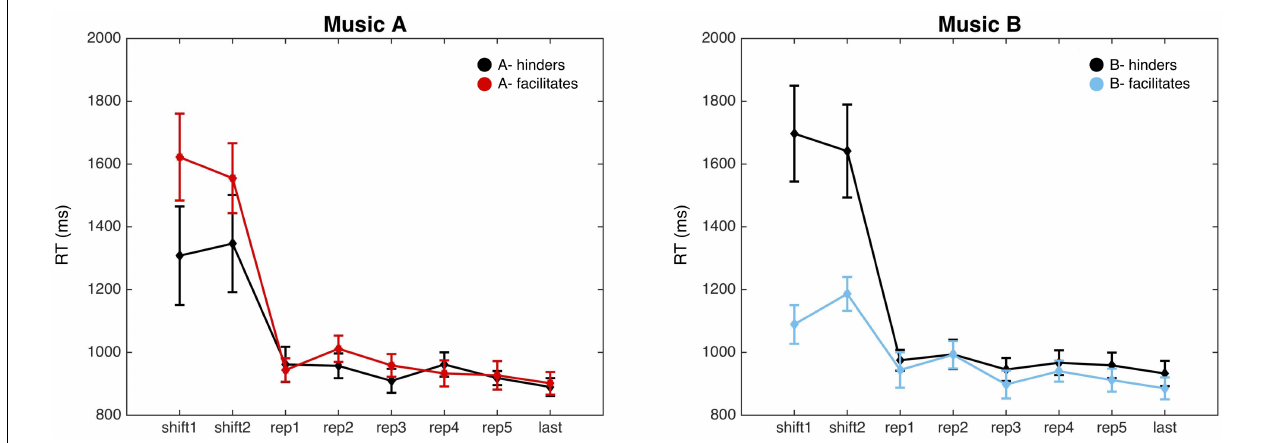
FIGURE 6 | RTs analyzed based on subjective experience. The left panel shows the RTs when music A facilitates or hinders the execution of the task. The right panel shows the RTs when music B facilitates or hinders the execution of the task. The X -axis shows the sequence of trial types and the Y -axis shows the time in milliseconds that it takes for the participants to respond. Error bars present the standard error of the